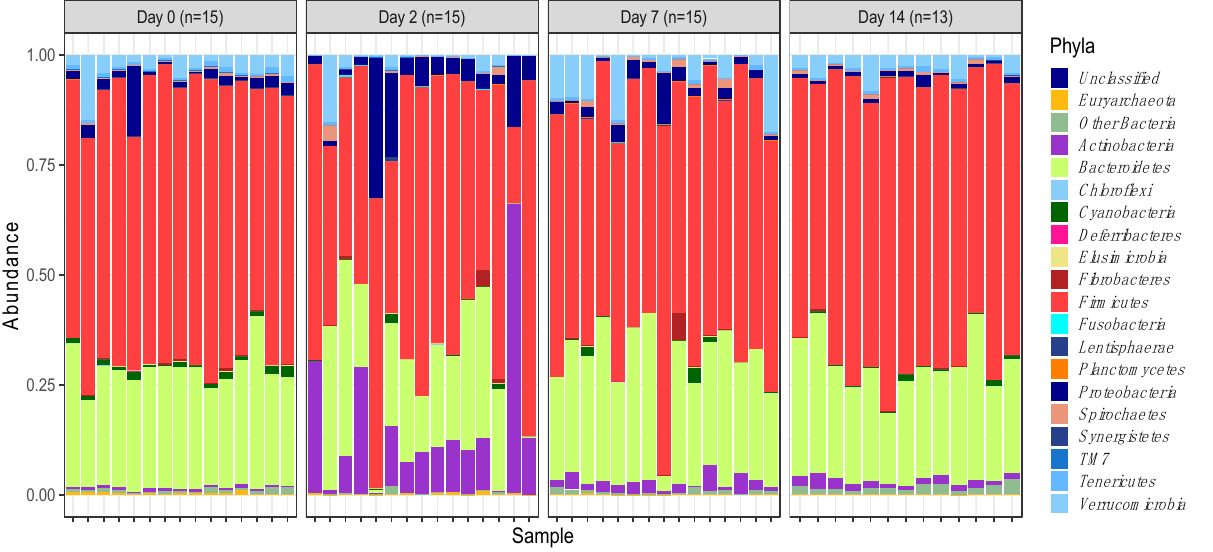
Figure 1. Phylum-level faecal microbiota assortment. Bar chart representing the relative abundance of all bacterial OTUs taxonomically classified at phylum level in each animal sampled on either the day of induction (day 0), or 2-, 7- and 14-days post induction.